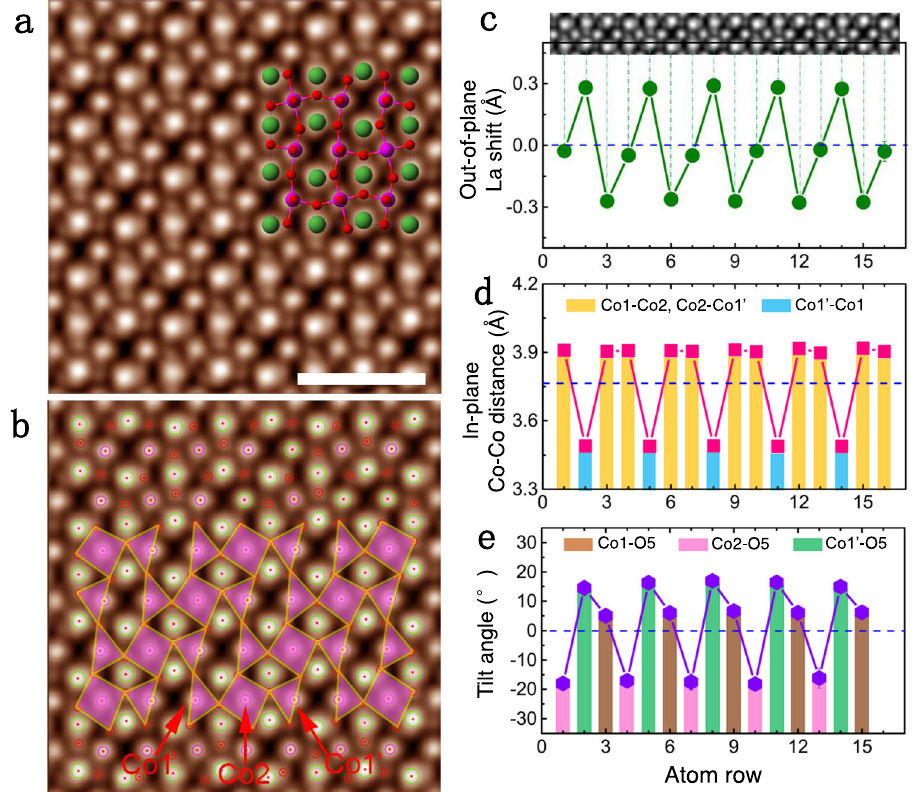
Fig. 3 Quantitative analysis on the atomic shift of La, Co ions, and tilt of [CoO5] square pyramids. a The iDPC image of the nLCO 2.5 phase. The structural model is overlaid to show the contrast assignment of La (green), Co (pink), and O (red) atoms. The scale bar is 1 nm. b Overlaid iDPC image in a by circles and polyhedra, where La, Co, and O atom columns are outlined by blue, pink, and red circles, respectively; projected CoO 5 square pyramids are labeled by pink polyhedral; three kinds of Co sites are also indicated by red arrows. c Periodic out-of-plane atomic shifts of La, where the HAADF image is inserted on the top to demonstrate the correspondence relationship. d Periodic in-plane Co – Co distances, where relatively small Co1 ′ -Co1 and large Co1- Co2, Co2-Co1 ′ distances are indicated by blue and yellow columns, respectively. e Tilt angles of CoO 5 square pyramids on Co1, Co2, and Co1 ′ sites, which are indicated by brown, pink, and green columns,